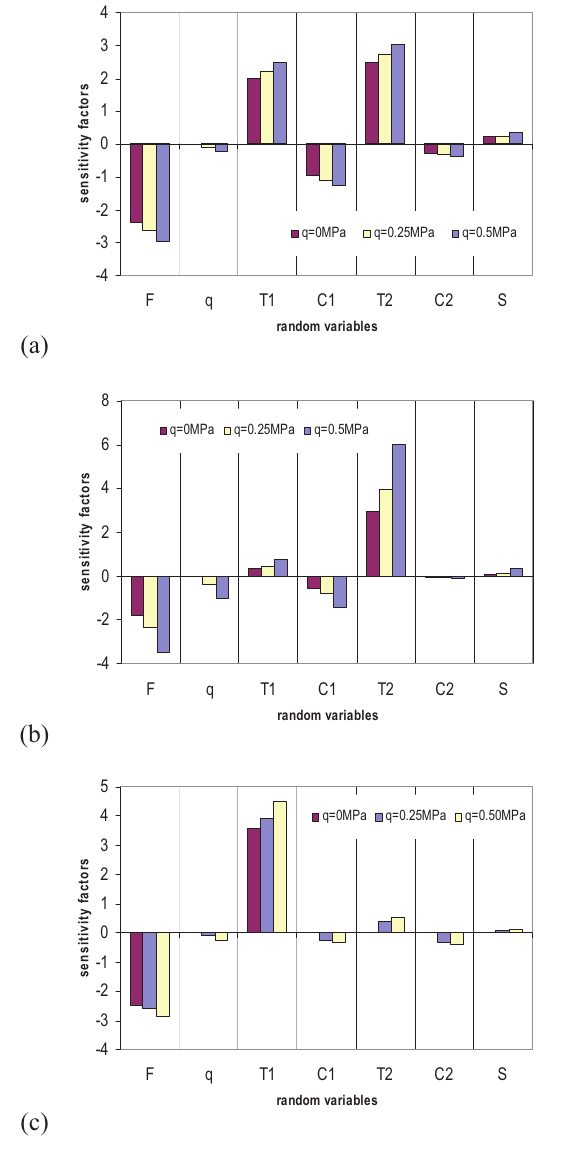
Fig. 10. Sensitivity analysis with respect to mean value of random variables ( P f ≈ 10 − 2 ): (a) carbon-epoxy, (b) glass- epoxy, (c) Kevlar-epoxy.